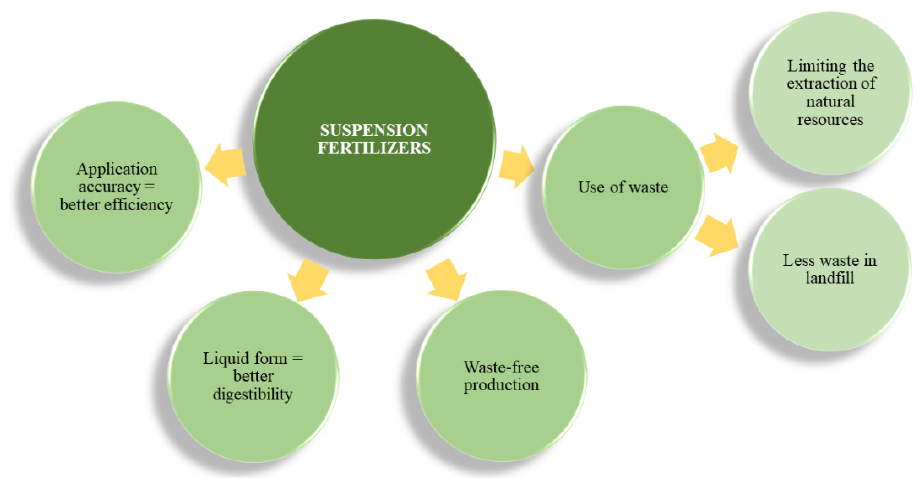
Figure 4. The positive impact of suspension fertilizers on the environment. The use of suspension fertilizers promotes the better use of fertilizing ingredients thanks to the liquid form and even distribution of the fertilizer in the field. The production of fertilizers is waste-free. The use of waste materials in their production results in the lower extraction of natural resources and a smaller amount of landfilled waste.